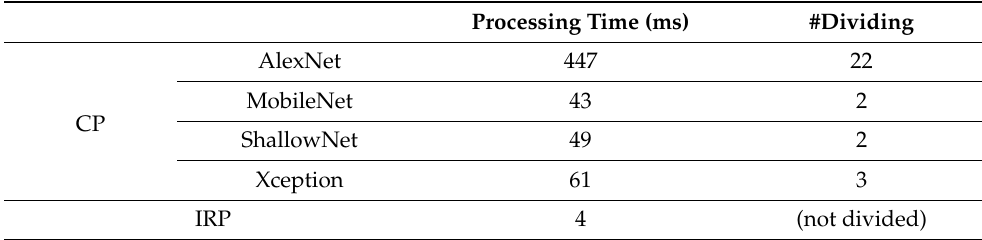
Table 3. Processing time with ultrasound back-end process in each network and the number of dividing for real-time